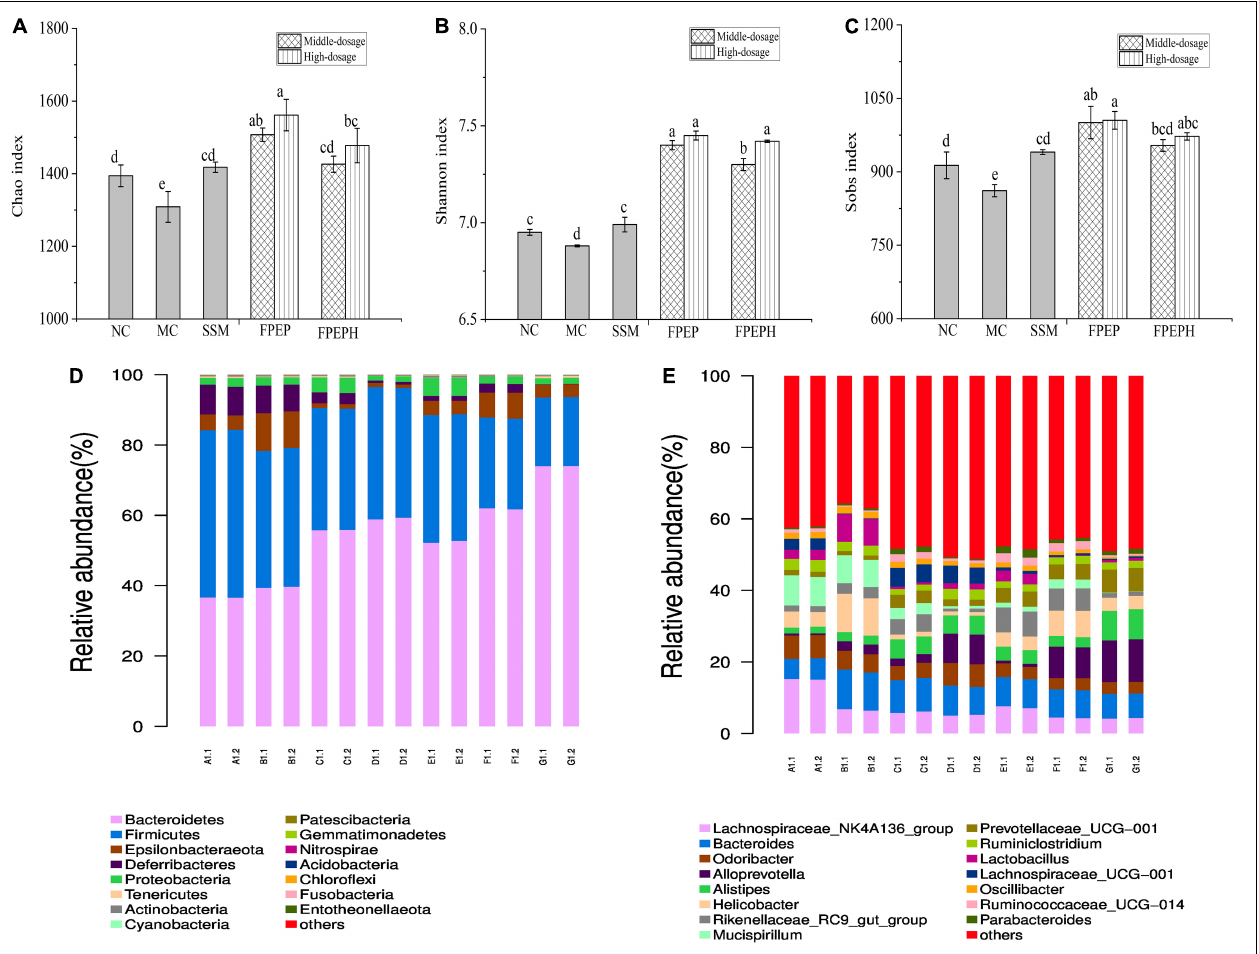
FIGURE 7 | Biodiversity measures, and compositions analysis on phylum and genus levels of the intestinal microbiota in all of the mice samples. (A–C) Alpha diversities index of Chao, Shannon, and Sobs, (D) Community barplot analysis on phylum level, and (E) Community barplot analysis on genus level. (Each group was measured twice in parallel. A: Middle-dosage of FPEP, B: High-dosage of FPEP, C: Middle-dosage of FPEPH, D: High-dosage of FPEPH, E: SSM, F: MC, G: NC). NC: control group; MC: model group; Vc: vitamin C-ascorbic acid; SSM: sour soybean milk; FPEP: fermented with P. eryngii polypeptides with a molecular weight of <3 kDa; FPEPH: fermented with P. eryngii protein hydrolysate; CAT: catalase; MDA: malondialdehyde; SOD: superoxide dismutase; T-AOC: total antioxidant